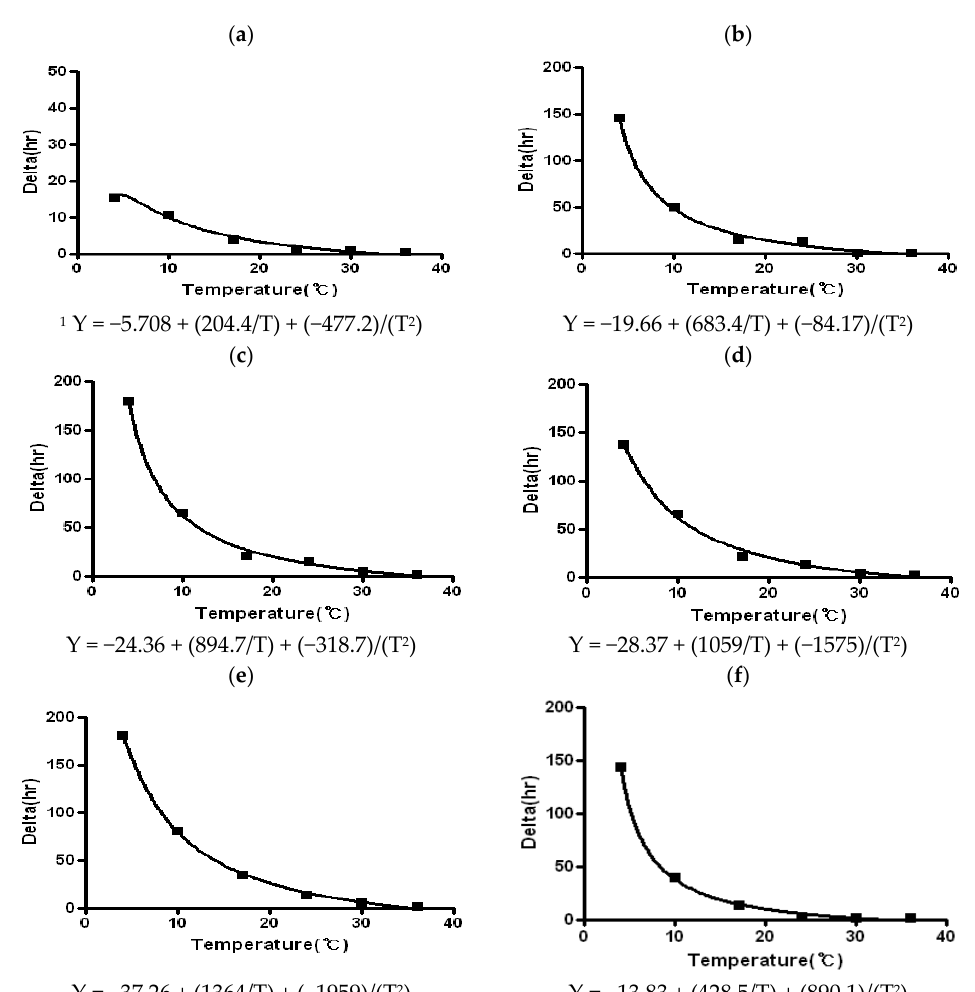
Figure 2. Secondary survival model of C. jejuni on vacuum packaged processed meat products as a function of temperature. ( a ) Dry-cured ham; ( b ) round ham with sodium nitrite; ( c ) garlic seasoning ham with sodium nitrite; ( d ) round ham without sodium nitrite; ( e ) garlic seasoning ham without sodium nitrite; and ( f ) sausage without sodium nitrite. 1 Davey model: Y = a + (b/T) + (c/T 2 ), T: temperature.